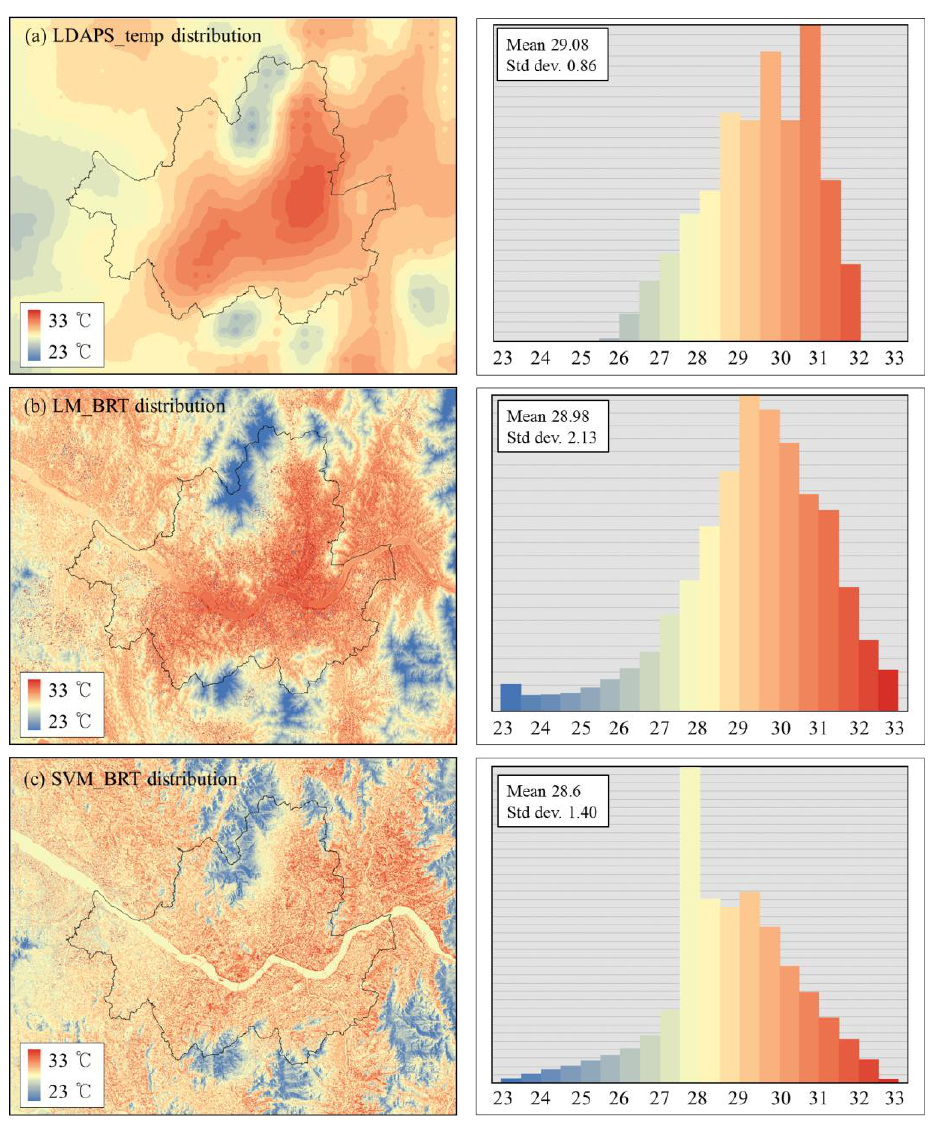
Figure 8. BRT distribution of daily maximum temperatures estimated for 30 August 2015. The left side of the figure shows the spatial distribution of temperatures, and the right side of the figure shows the zonal histogram for the areas within the boundary of Seoul City.